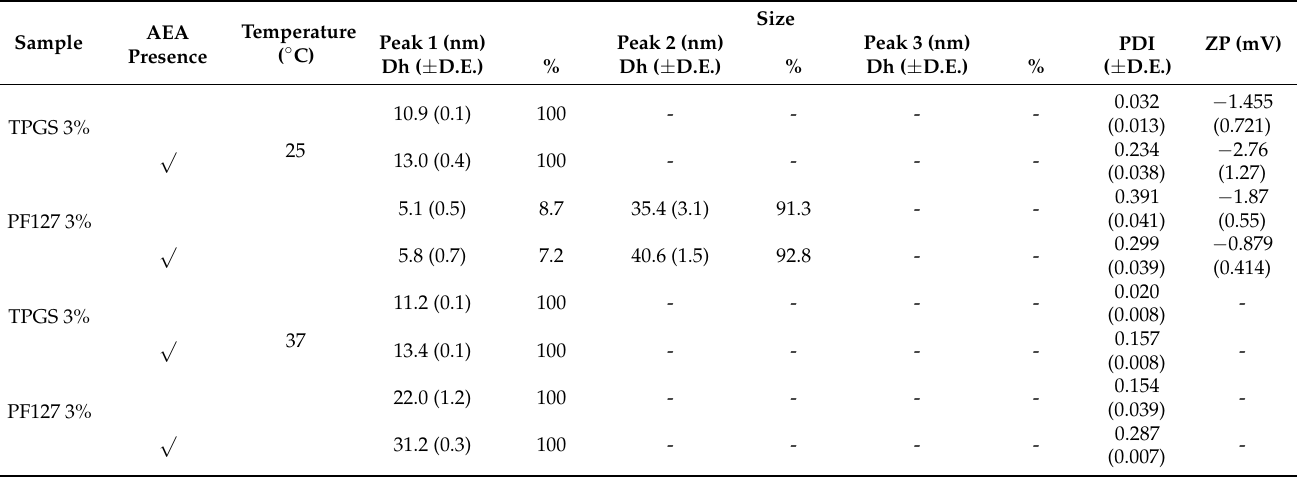
Table 1. DLS analysis of TPGS and PF127 micelles: The measurements were performed on both empty and AEA-loaded nanomicelles, at 25 ◦ C and 37 ◦ C. n = 3. Dh: average hydrodynamic